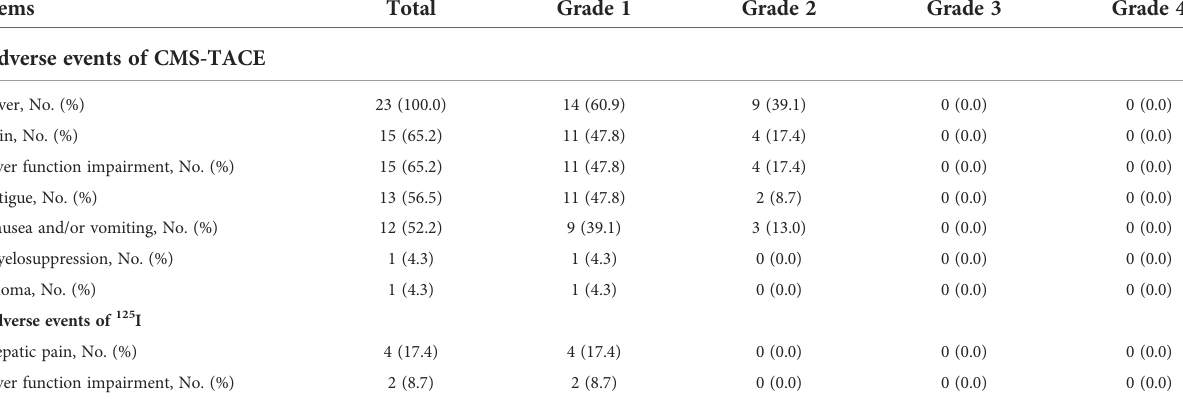
TABLE 4 Adverse events.